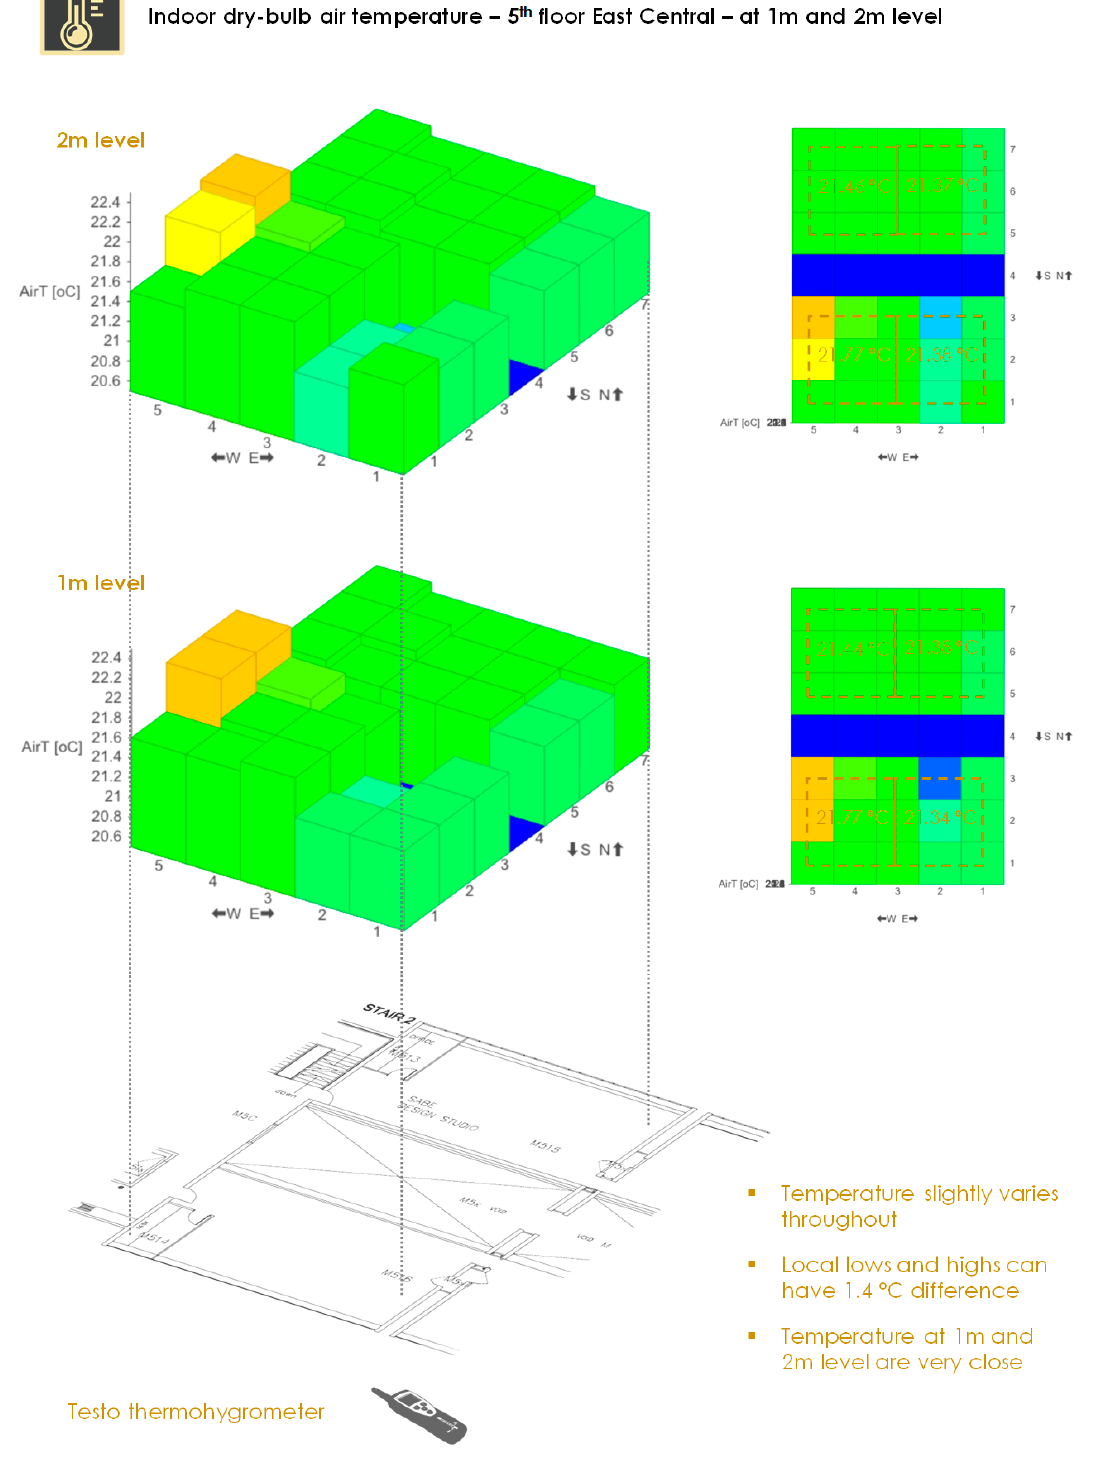
Figure A6. Variations of Indoor DBT levels at the 5th floor studio spaces (source: spot measurements plotted by the author; an icon has been used in this figure retrieved from Flaticon.com) [40].